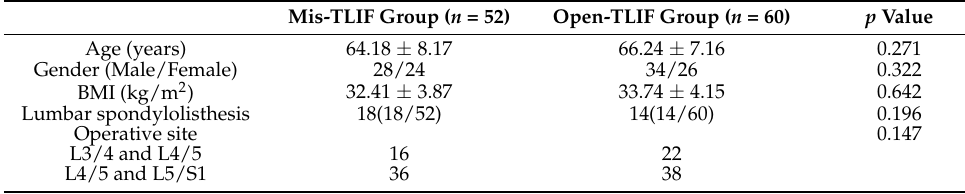
Table 1. General information of the two